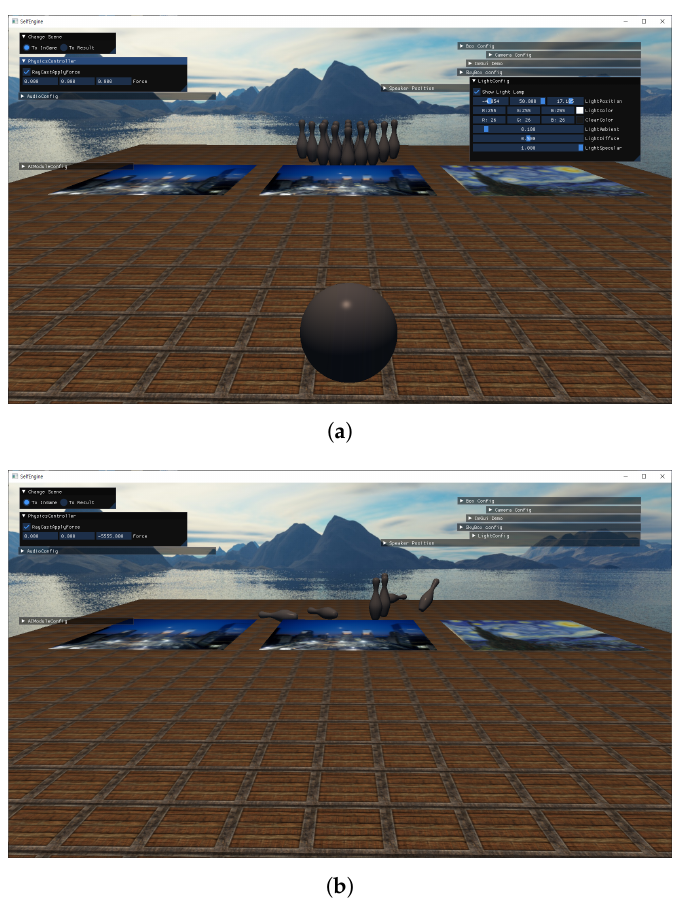
Figure 6. Screenshots from the bowling game. ( a ) Before a collision, ( b ) after the collision.